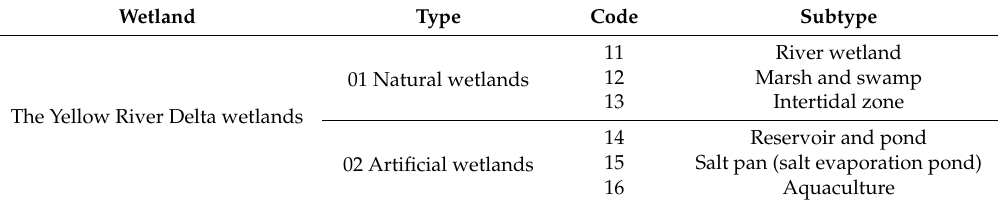
Table 2. Classification system for regional wetland remote-sensing